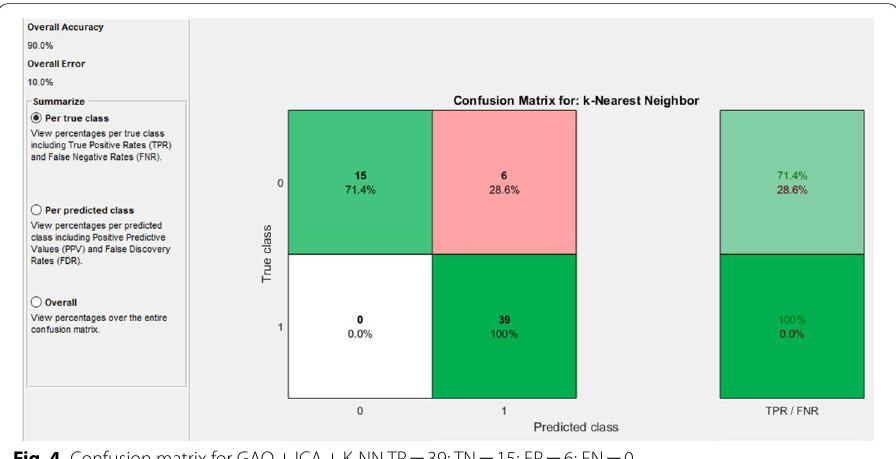
Fig. 4 Confusion matrix for GAO Table 2 Performance Metrics Table for the GAO Classification Performance metrics (%) GAO Accuracy 88.3